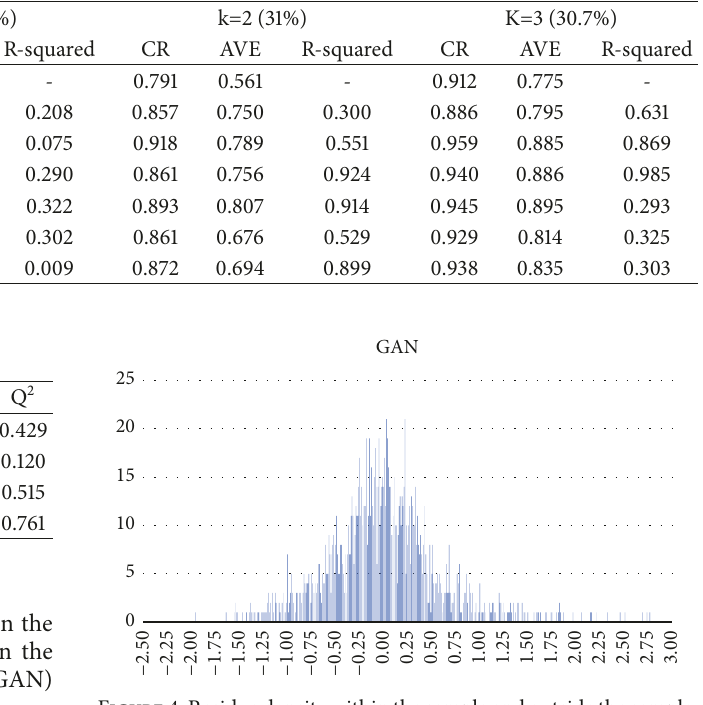
Figure 4: Residuedensity within thesample and